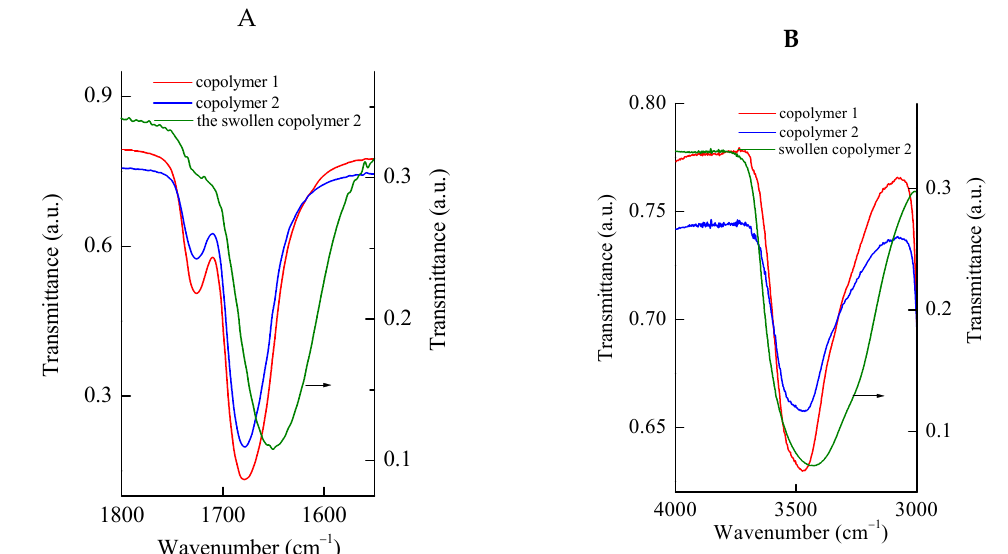
Figure 1. ( A ) IR spectra of the copolymers 1 and 2 films cast from chloroform and swollen in water copolymer 2 in the regions of 1600–1800 and ( B ) 3000–4000 cm − 1 .